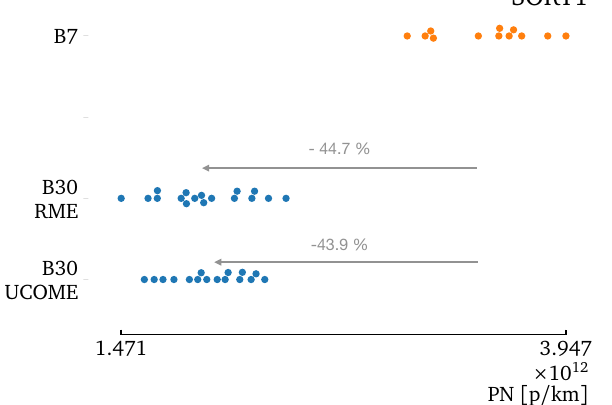
Figure 10. The PN emission rate per kilometre of each SORT 1 repetition shows lower PN emissions when the bus is fueled with B30 RME and B30 UCOME compared to